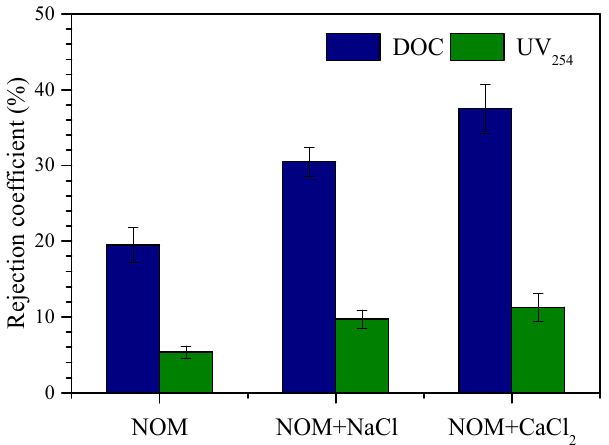
Figure 4. Performance of organic rejection during treatment of reconstituted NOM solution using ultrafiltration (UF). The DOC concentration and UV 254 of the feed water were 5.72 mg L − 1 and 0.187 cm − 1 , respectively. Error bars indicate the standard error of triplicate measurements.